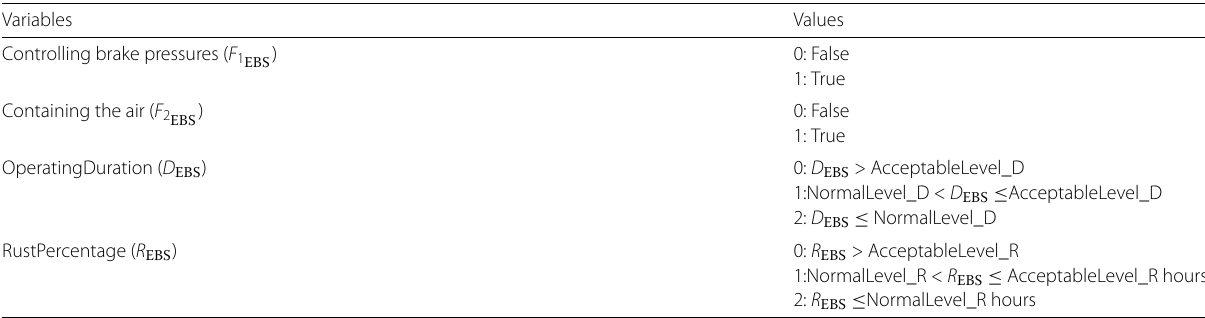
Table 2 Variables for the equipment level: EBS module Variables